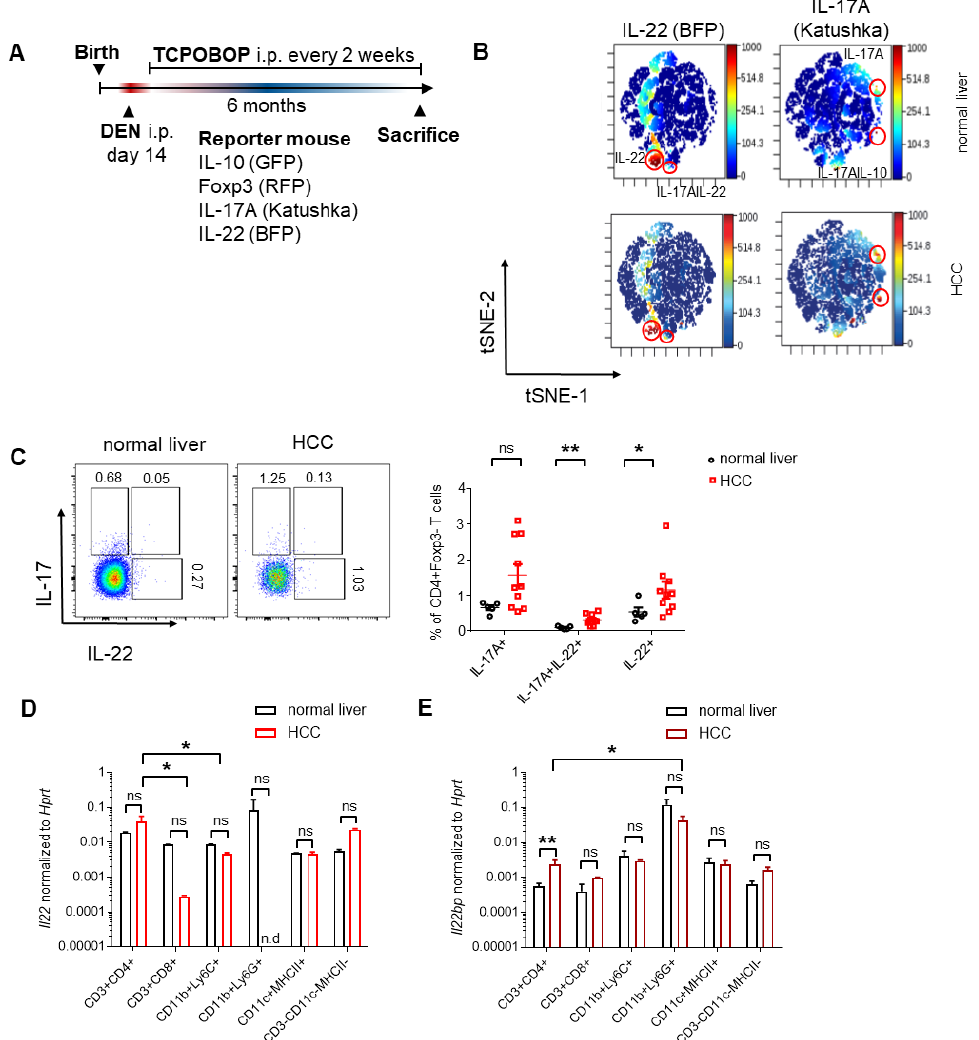
Figure 3. T h 22 cells and neutrophils comprise the major cellular sources of IL-22 and IL-22BP in HCC, respectively. ( A ) A schematic timeline describing chemical HCC induction with DEN and TCPOBOP in mice; ( B ) unbiased tSNE-analysis of CD45 + leucocytes analyzed with FACS isolated from the healthy murine liver (upper panel, n = 5) or murine liver after chemical induction of HCC (lower panel, n = 5), color change indicates levels of IL-22 (left panels) or IL-17A (right panels); ( C ) left: representative FACS dot plots of CD45 + CD3 + CD4 + Foxp3 - leucocytes analyzed with FACS isolated from the healthy murine liver (left) or murine liver after chemical induction of HCC (right); right: percentage of IL-17A + IL-22 - (left), IL-17A + IL-22 + (middle) and IL-17A - IL-22 + (right) CD45 + CD3 + CD4 + Foxp3 - leucocytes analyzed with FACS isolated from the healthy murine liver (black, n = 5) or murine liver after chemical induction of HCC (red, n = 5); ( D ) relative expression of IL22 in comparison to HPRT of indicated leucocyte subsets isolated from either healthy murine liver (black, n = 3 pooled samples of sorted cells, for each pooled sample 4 mice were used) or murine liver after chemical induction of HCC (red, n = 3 pooled samples of sorted cells, for each pooled sample 4 mice were used). ( E ) relative expression of IL22bp in comparison to HPRT of indicated leucocyte subsets isolated from either healthy murine liver (black, n = 12) or murine liver after chemical induction of HCC (red, n = 12). Leucocytes were all cell-sorted on CD45 + and then on indicated markers. Data are pooled from 2 independent experiments. Data presented as mean ± SEM. ns: p > 0.05; *: p < 0.05; **: p ≤ 0.01 as assessed by Mann–Whitney U